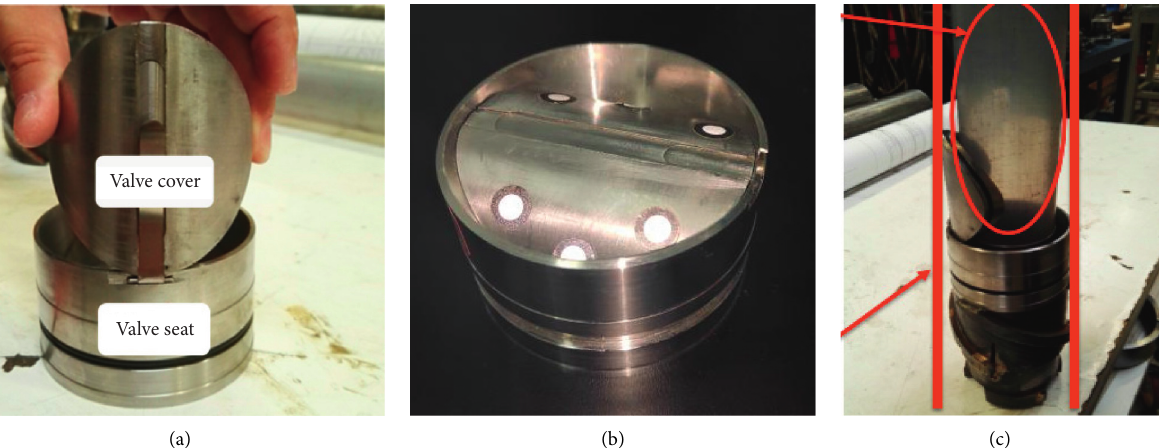
Figure 1: Square cover solid drawing.